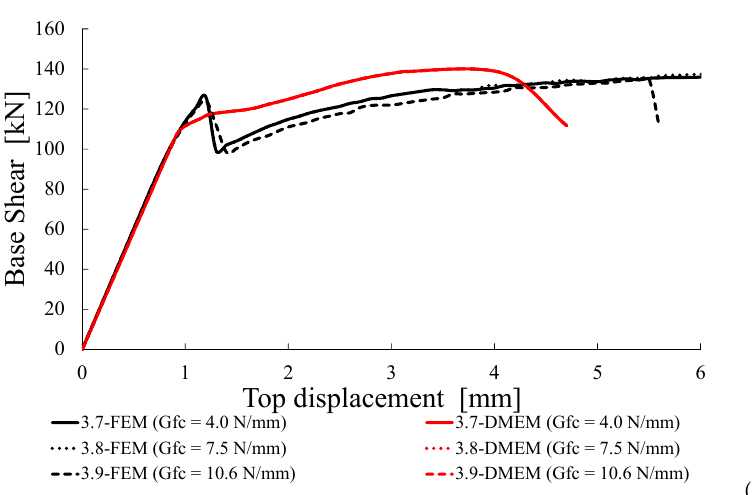
Figure 13. Capacity curves for Group C: ( a ) σ 0 = 0.3 MPa and f c = 3.0 MPa, ( b ) σ 0 = 0.3 MPa and f c = 4.5 MPa, ( c ) σ 0 = 0.6 MPa and f c = 4.5 MPa.